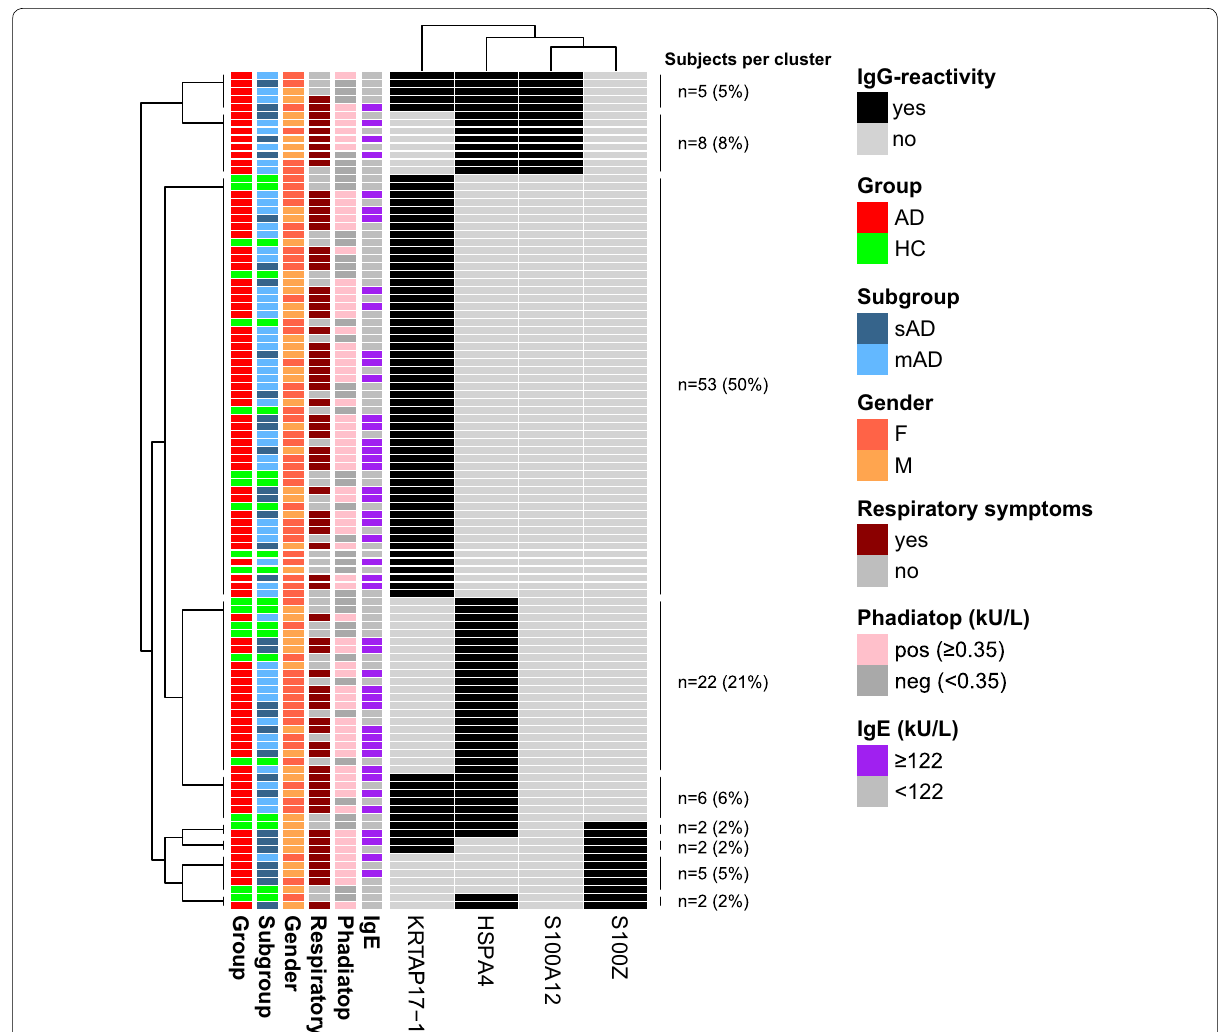
Fig. 4 Hierarchical clustering of subjects with IgG-reactivity to the antigens representing KRTAP17-1, HSAP4, S100A12 and S100Z. Clustering of the subjects showing positive IgG-reactivity to any of the four antigens when analyzed using antigen bead arrays. The number of subjects in each cluster and percentage of all subjects with IgG-reactivity are shown. Clinical characteristics annotated in rows. Respiratory symptoms included a history of or current rhinoconjunctivitis and/or asthma. HC healthy control, AD atopic dermatitis, mAD moderate AD, sAD severe AD, F female, M